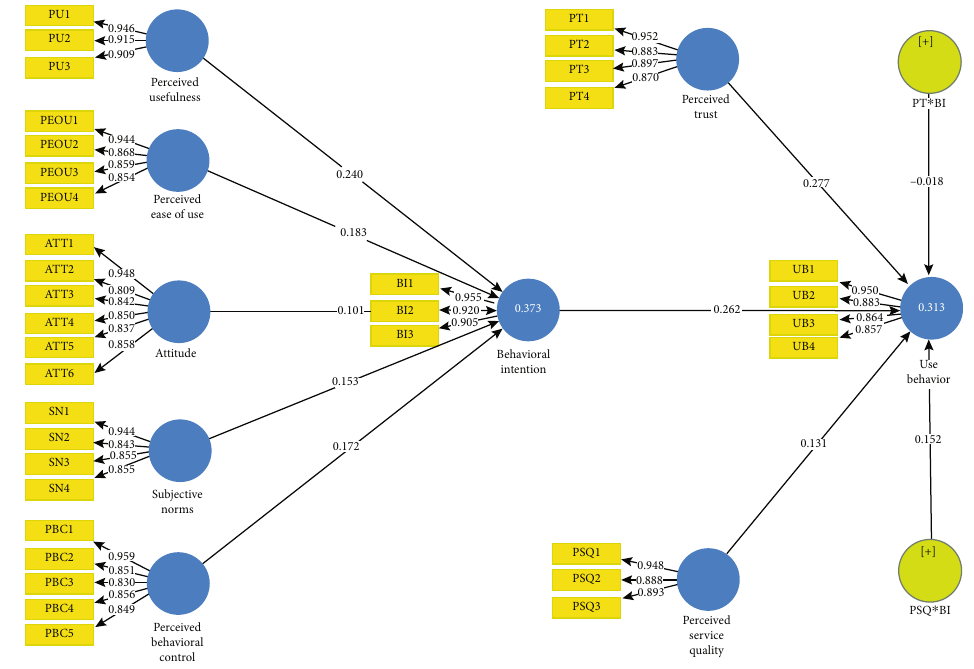
Figure 2: Path diagram of structural model.